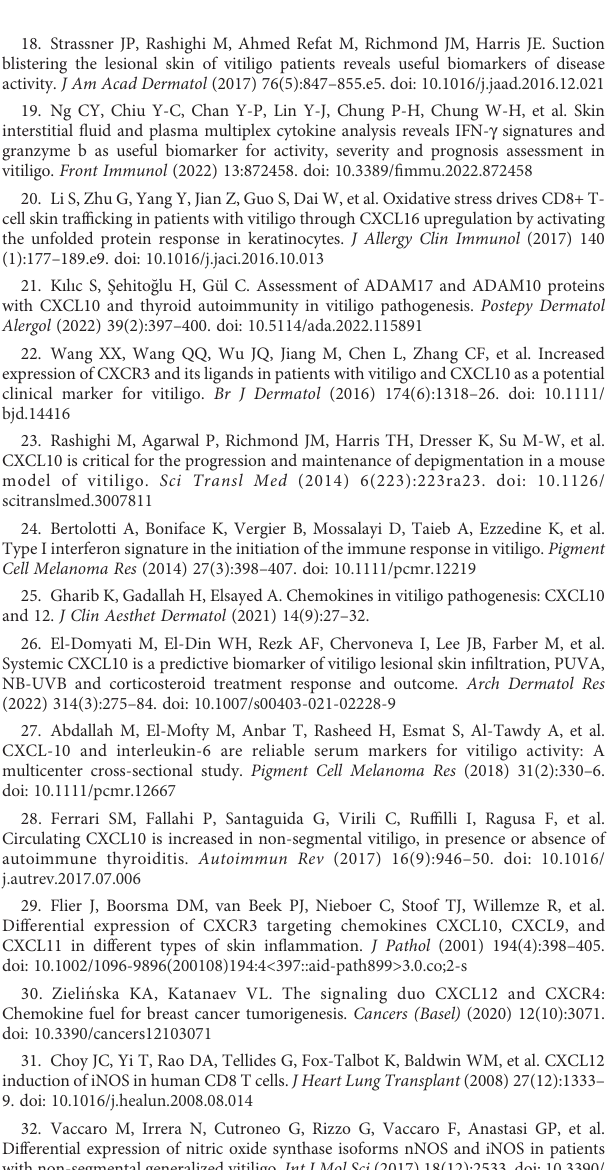
SUPPLEMENTARY FIGURE 1 PRISMA fl ow diagram. SUPPLEMENTARY FIGURE 2 Meta-analysis of chemokines at the protein level in skin blister fl uid of vitiligo